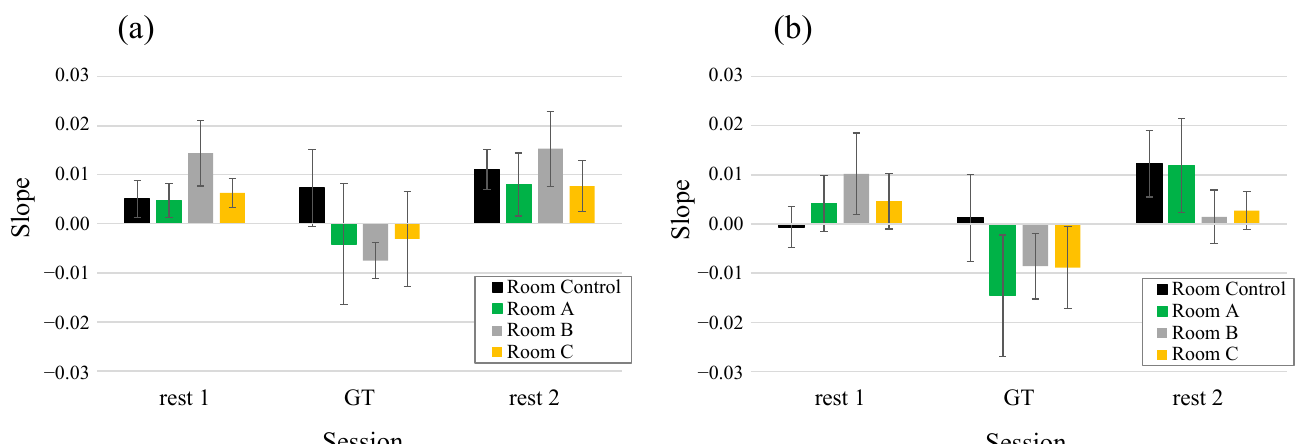
Figure 9. The mean values of the slope for oxygenated hemoglobin in 1-min periods immediately after the start of rest 1, GT, and rest 2 sessions. ( a ) Left prefrontal cortex and ( b ) right prefrontal cortex. Data are expressed as mean ± standard errors ( n = 7). GT, test space; Room Control, space without natural green features; Room A/B/C, space with natural green features.